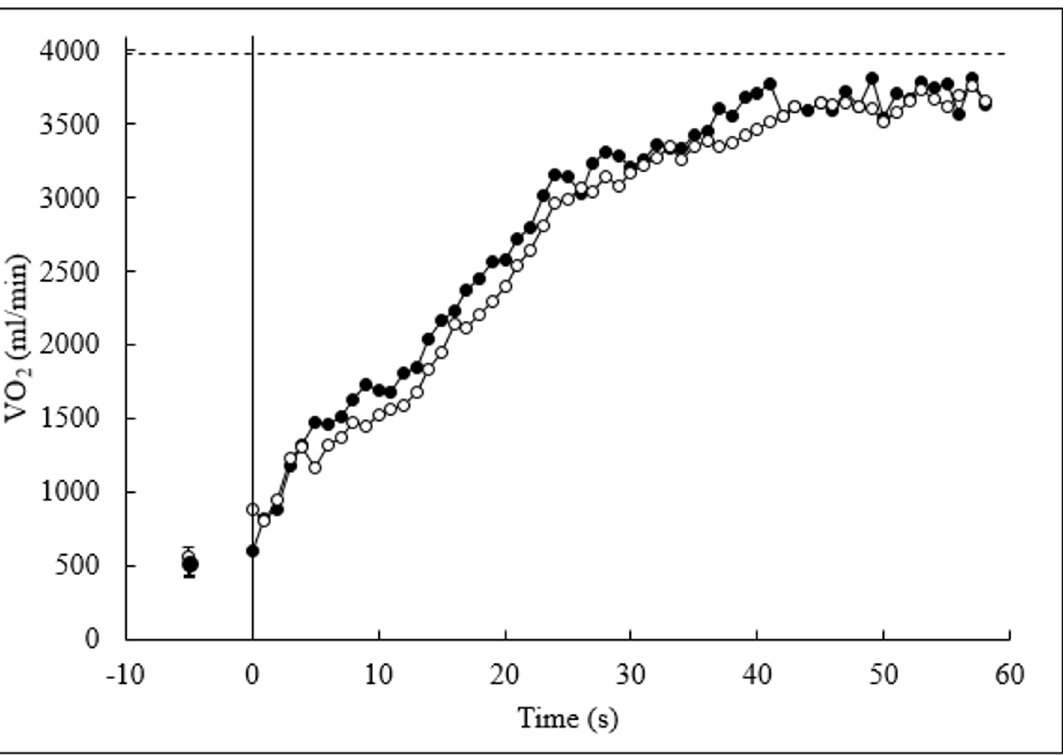
Figure 2. Group mean pulmonary V˙ O 2 response during the highest speed and fast-start pacing strategy. For graphical presentation, data were matched at the shortest time to exhaustion recorded and interpolated to show second-by-second values. The vertical solid line represents the onset of exercise and the horizontal dashed line is the mean V˙O 2 max. The mean 6 SD of pre-test V˙O 2 in each condition are also shown.